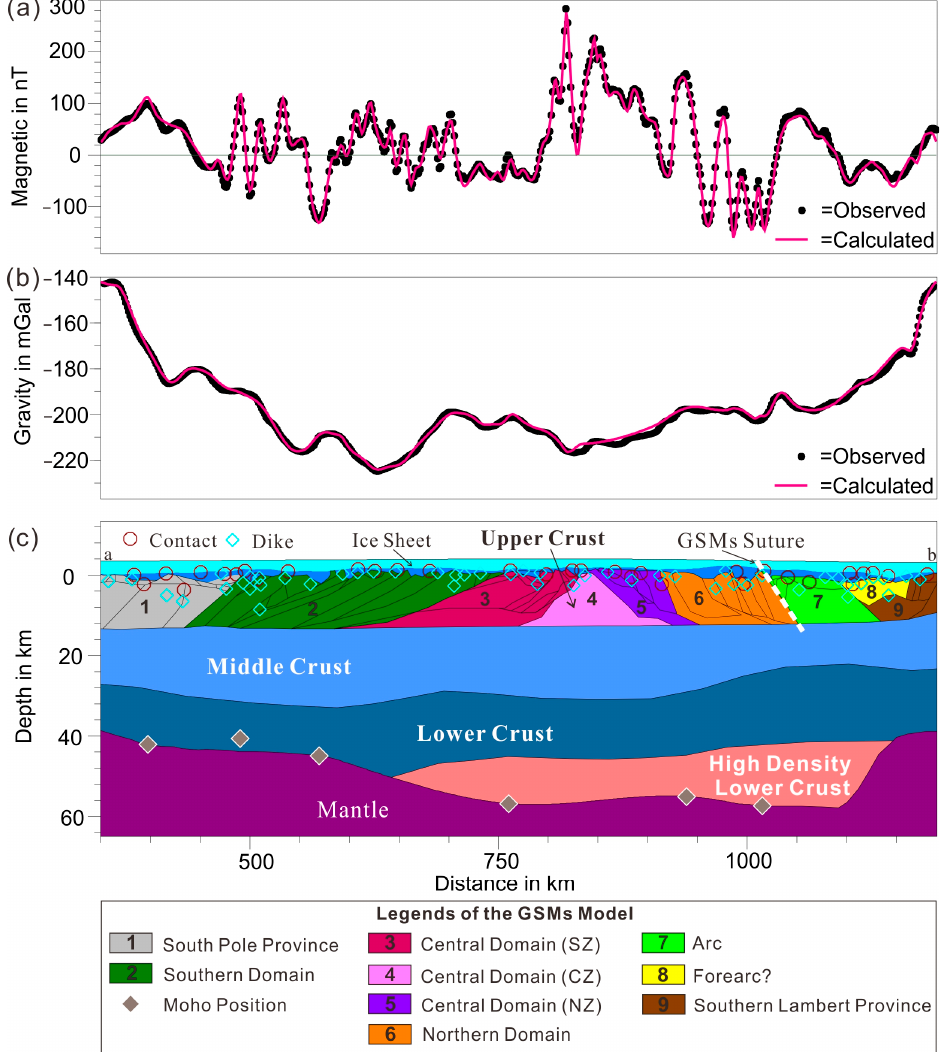
Figure 5. 2D gravity and magnetic model of the GSMs. The density and susceptibility settings of the individual layers in this model are shown in Appendix A. ( a ) Observed aeromagnetic data (black dots) and calculated magnetic data (red line) from the 2D model shown in (c). ( b ) Observed airborne gravity data (black dots) and calculated gravity data (red line) from the 2D model shown in (c). ( c ) 2D model revealing the crustal architecture of the GSMs.